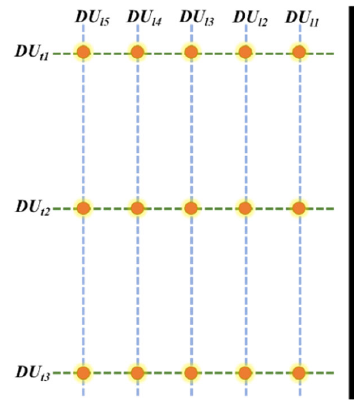
Figure 10. Schematic of the comprehensive DU calculation. According to the sampling area, there were three sampling zones in each longitudinal column, five sampling areas in each transverse row, and 15 calculated values were obtained by combining them; these values represent the transverse and longitudinal uniformity of the sample areas, respectively.